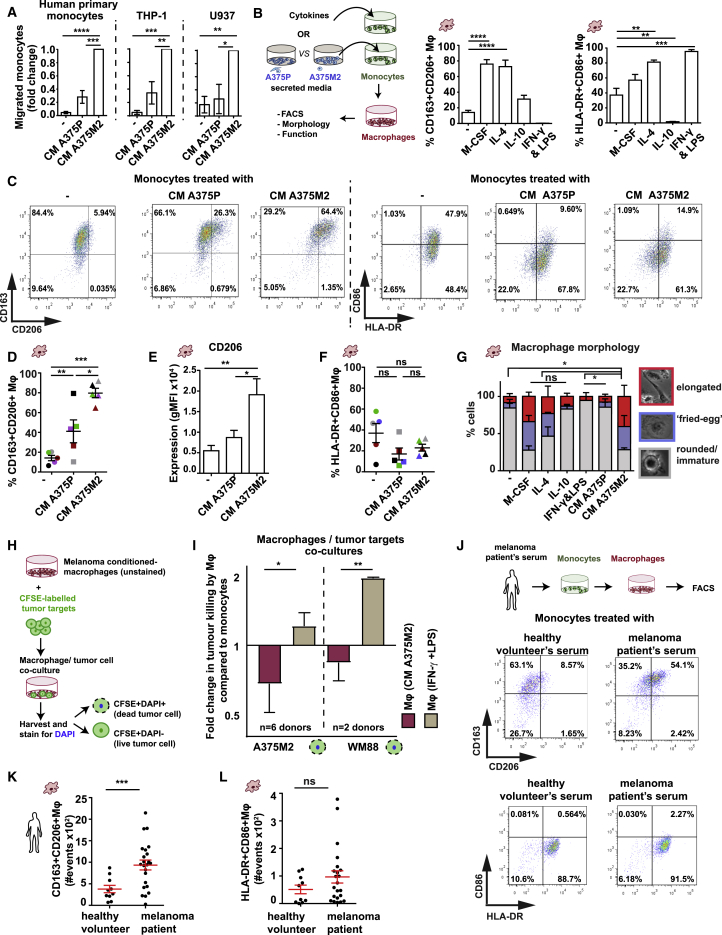
Amoeboid Melanoma Cells Induce Tumor-Promoting Macrophages(A) Percentage of migrated human PBMC-derived monocytes, THP-1 and U937 toward media (–), CM A375P, or CM A375M2 (n = 3).(B) (Left) Schematic: in-vitro-polarized macrophages or melanoma-conditioned macrophages and (right) %CD163+CD206+ or %HLA-DR+CD86+ macrophages after treatment with M-CSF, IL-4, IL-10, or IFN-γ&LPS or media only (–) (n = 5;5 different healthy donors).(C) Fluorescence-activated cell sorting (FACS) dot plots from one donor showing (left) %CD163+CD206+ and (right) %HLA-DR+CD86+ macrophages after treatment with CM A375P, CM A375M2 or culture media only (–).(D–F) %CD163+CD206+ macrophages (D), mean fluorescence intensity (MFI) for CD206 (E), and %HLA-DR+CD86+ macrophages (F), after treatment with CM A375P, CM A375M2, or culture media only (–) (n = 5;5 different healthy donors).(G) Quantification of macrophage morphology (see also Figure S3D) (n = 3;3 different healthy donors).(H) Schematic shows macrophage cytotoxicity assay.(I) Fold change of dead tumor cells (A375M2 or WM88) in co-cultures with PBMC-derived monocytes treated with CM A375M2 or IFN-γ&LPS. Data are presented as fold change versus the control untreated monocytes. Log2 scale is presented in y axis (n = 6;6 different healthy donors for A375M2 co-cultures and n = 2;2 different healthy donors for WM88 co-cultures).(J) (Top) Schematic shows TAMs induction in vitro with serum from melanoma patients and (bottom) representative FACS dot plots from one donor showing %CD163+CD206+ and %HLA-DR+CD86+ macrophages after treatment with healthy volunteer’s serum or melanoma patient’s serum.(K and L) Number of (K) CD163+CD206+ and (L) HLA-DR+CD86+ macrophages after treatment with healthy volunteer’s serum or melanoma patient’s serum (n = 3;3 different healthy donors. Sera from n = 10 healthy volunteers, n = 23 melanoma patients, each dot represents a different treatment).In (A), (B), (D)–(G), (I), (K), and (L), graphs and dot blots show mean ± SEM. In (A), (B), and (D)–(G), one-way ANOVA with Tukey or Bonferroni (for G) post hoc tests are shown. In (I), t test is shown. In (K) and (L), t test with Welch’s correction is shown. Nonsignificant p > 0.05, ∗p < 0.05, ∗∗p < 0.01, ∗∗∗p < 0.001, ∗∗∗∗p < 0.0001.See also Figure S3 and Tables S1 and S2.